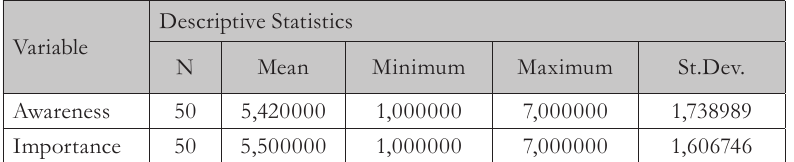
Tab. 2 – The descriptive statistics regarding the answers related to Awareness and Importance questions. Source: Own processing at STATISTICA,